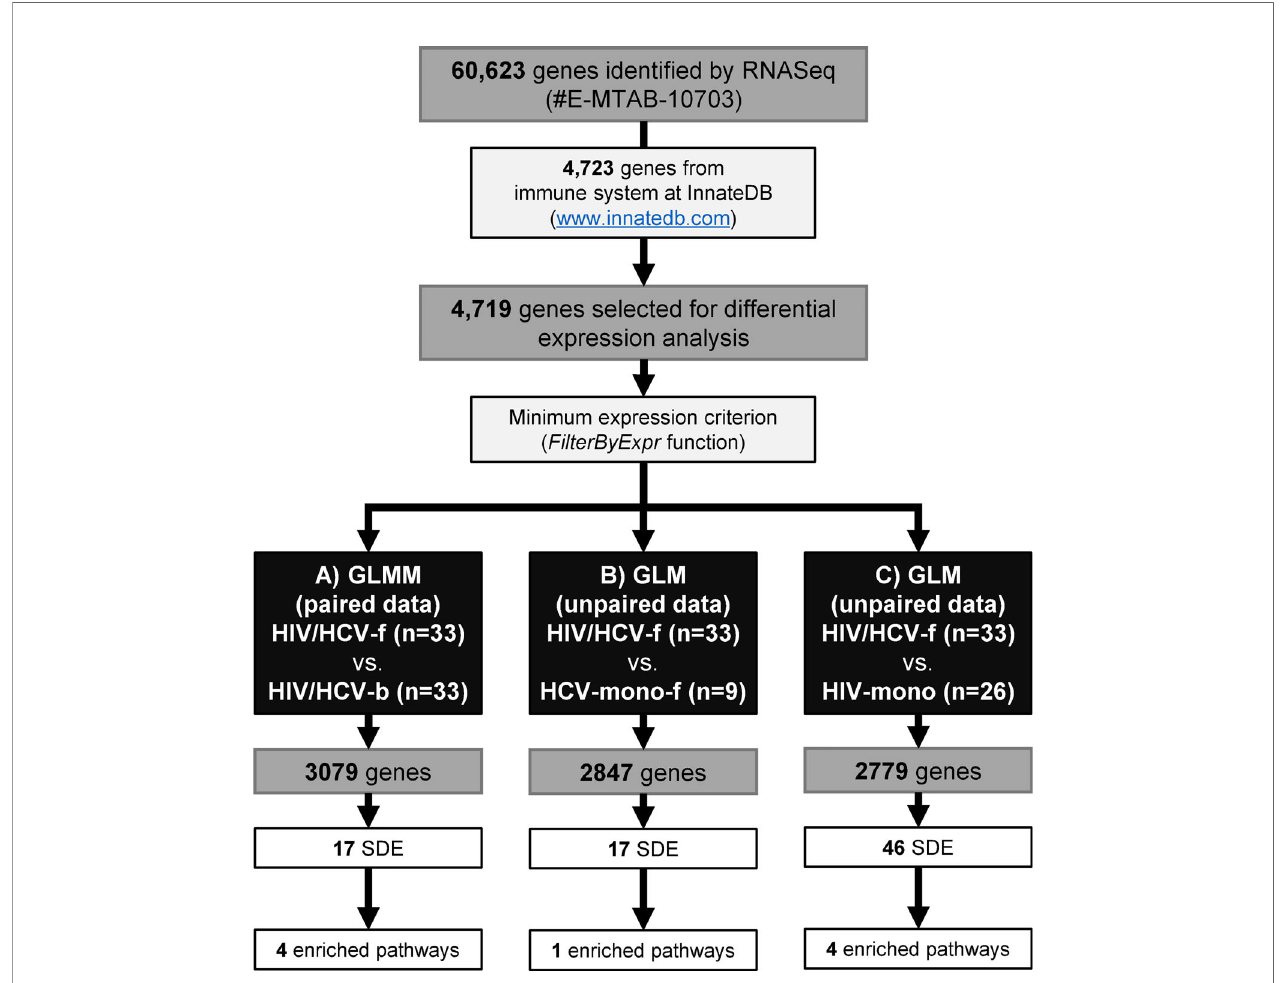
FIGURE 1 | Study design fl owchart. RNA sequencing identi fi ed a total of 60,623 genes. Of these, we selected 4,723 genes of the immune system from the InnateDB. A total of 4,719 genes were selected for the differential expression analysis. Next, the FilterByExpr function was applied for each comparison: (A) HIV/ HCV-f vs. HIV/HCV-b, 3,079 genes were selected, 17 were SDE genes involved in four biological pathways; (B) HIV/HCV-f vs. HCV-mono-f, 2,847 genes were selected, 17 were SDE genes involved in one biological pathway; (C) HIV/HCV-f vs. HIV-mono, 2,779 genes were selected, 46 were SDE genes involved in four biological pathways. HIV, human immunode fi ciency virus; HCV, hepatitis C virus; HIV/HCV-f, HIV/HCV-coinfected patients 36 weeks after the sustained virological response (SVR); HCV-mono-f, HCV-monoinfected patients 36 weeks after SVR; HIV-mono, HIV-monoinfected patients; SDE, signi fi cantly differentially expressed; GLM, generalized linear model; GLMM, Generalized linear mixed